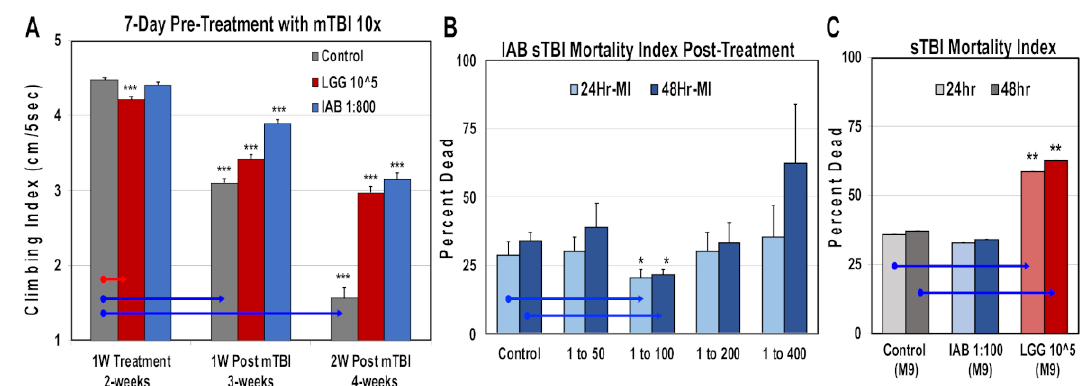
Figure 6. Impact of biologic treatments on trauma responses. ( A ) Geotaxis profiles of flies pre-treated with LGG (10 5 CFUs) or IAB (1:800), as well as one and two weeks following mTBI. See Table S5 for additional information. ( B ) Young flies were given different IAB dilutions two days before sTBI-1 × exposure. Dead flies were counted after 24 h and 48 h, and used to calculate mortality indexes (MIs). ( C ) The MI profiles of control ( n = 78) flies, as well the pre-treated (two days) with IAB (1:800, n = 79) or LGG (10 5 CFUs, n = 75) fly cohorts. (* p -values < 0.5, ** p -values < 0.01, *** p -values < 0.001). See Supplementary Table S5 for additional fly numbers ( n ) and information.